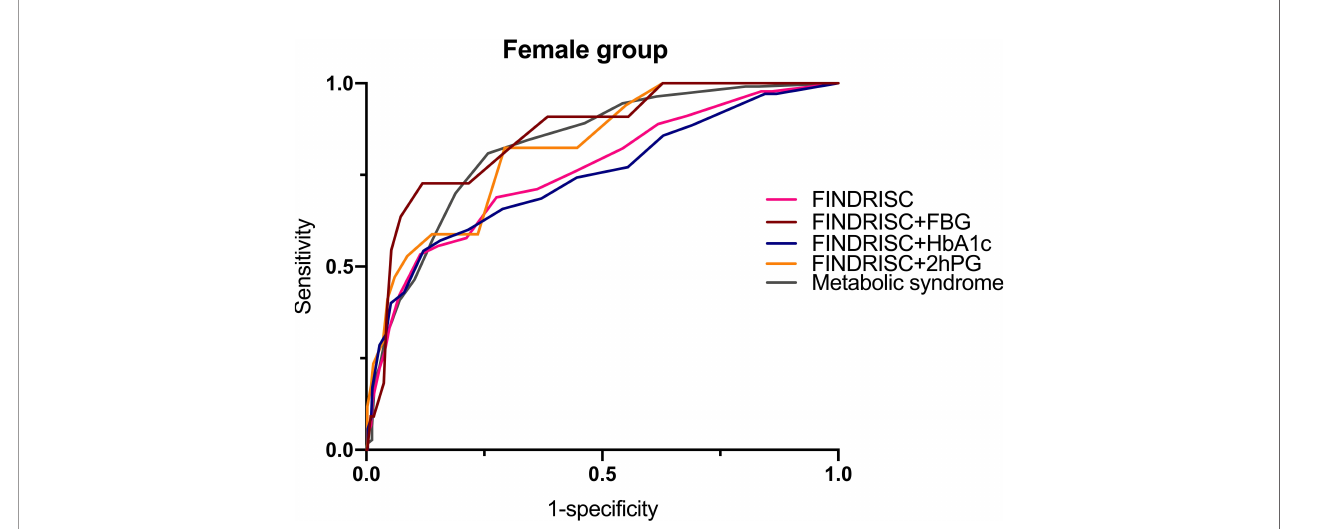
FIGURE 1 | FINDRISC area under ROC curve (AUC) for identifying T2DM in female